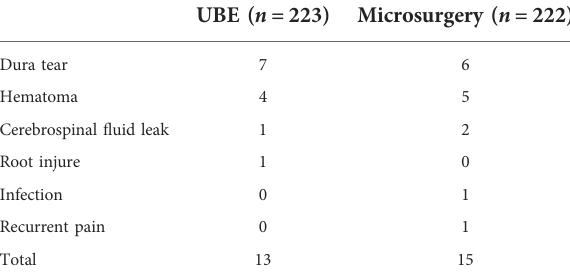
TABLE 3 Comparison of complications between the two